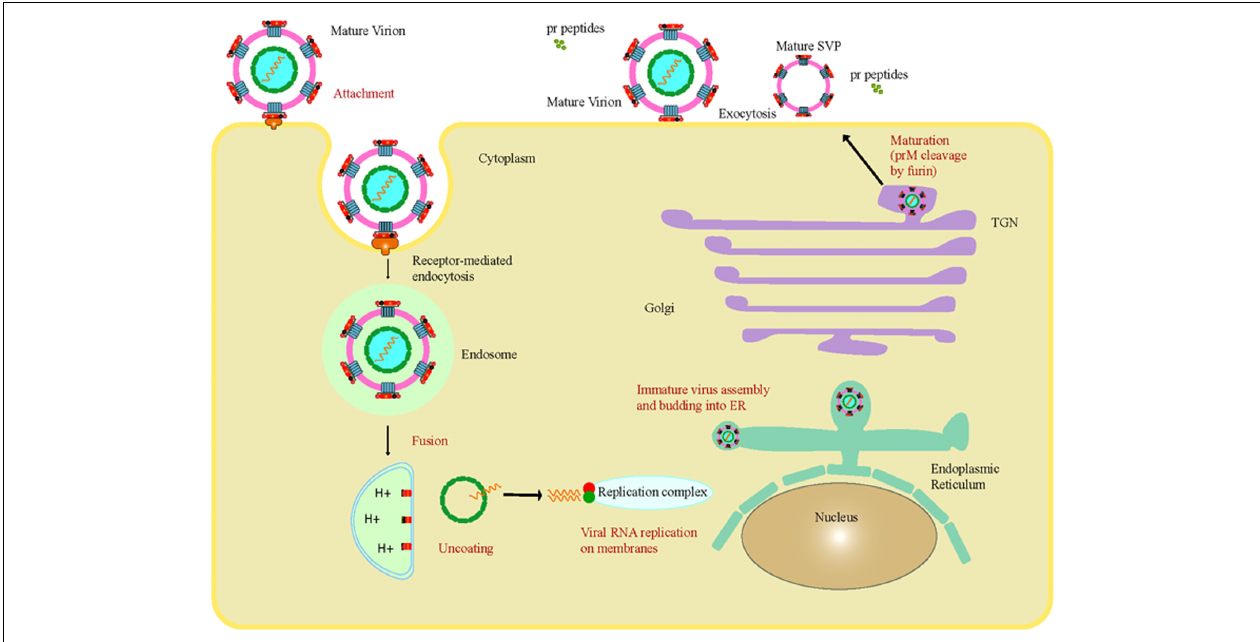
FIGURE 2 | The major events occurred in the replication and maturation of ZIKV inside the host cell followed by their release into the environment resulted in spread of the